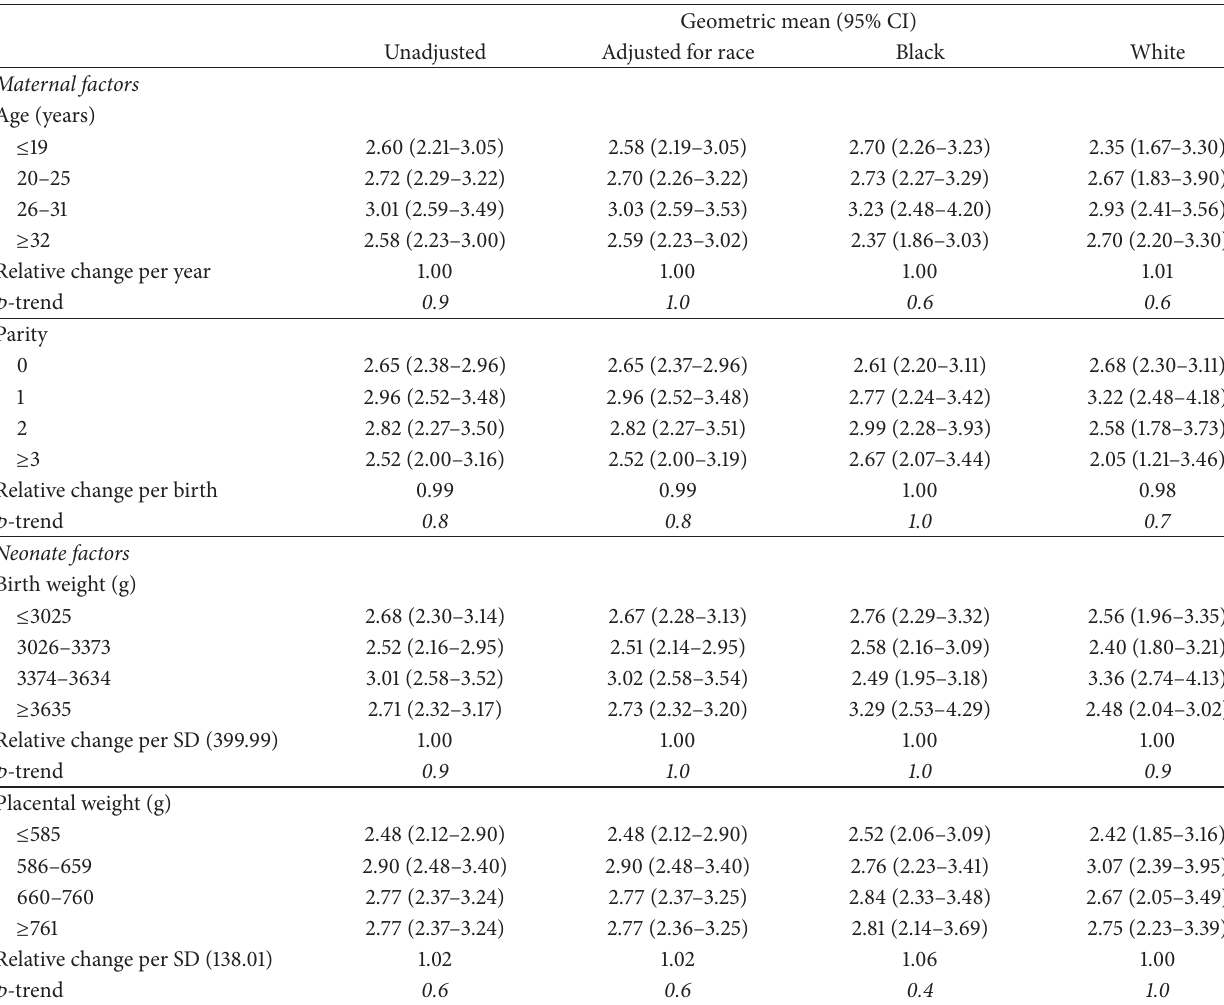
Table 2: Geometric mean relative telomere length in umbilical cord blood leukocytes by maternal and neonate factors, overall and by race, males in the hormones in umbilical cord blood